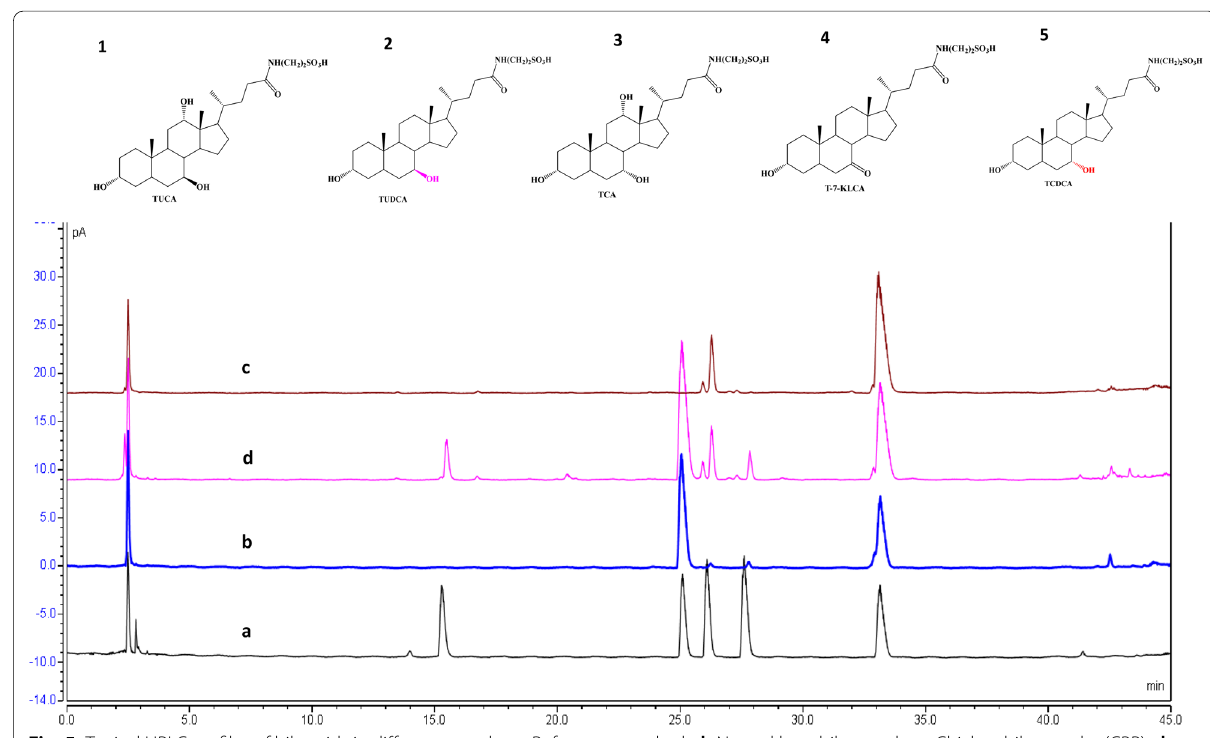
Fig. 5 Typical HPLC profiles of bile acids in different samples. a Reference standards. b Natural bear bile powder. c Chicken bile powder (CBP). d Biotransformation products from CBP. Compound 1 : tauroursocholic acid (TUCA). Compound 2 : tauroursodeoxycholic acid (TUDCA). Compound 3 : tauro-7-keto lithocholic acid (T-7-KLCA). Compound 4 : taurocholic acid (TCA). Compound 5 : taurochenodeoxycholic acid